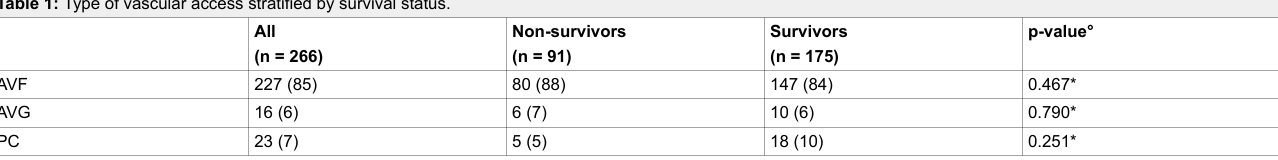
Table 1: Type of vascular access stratified by survival